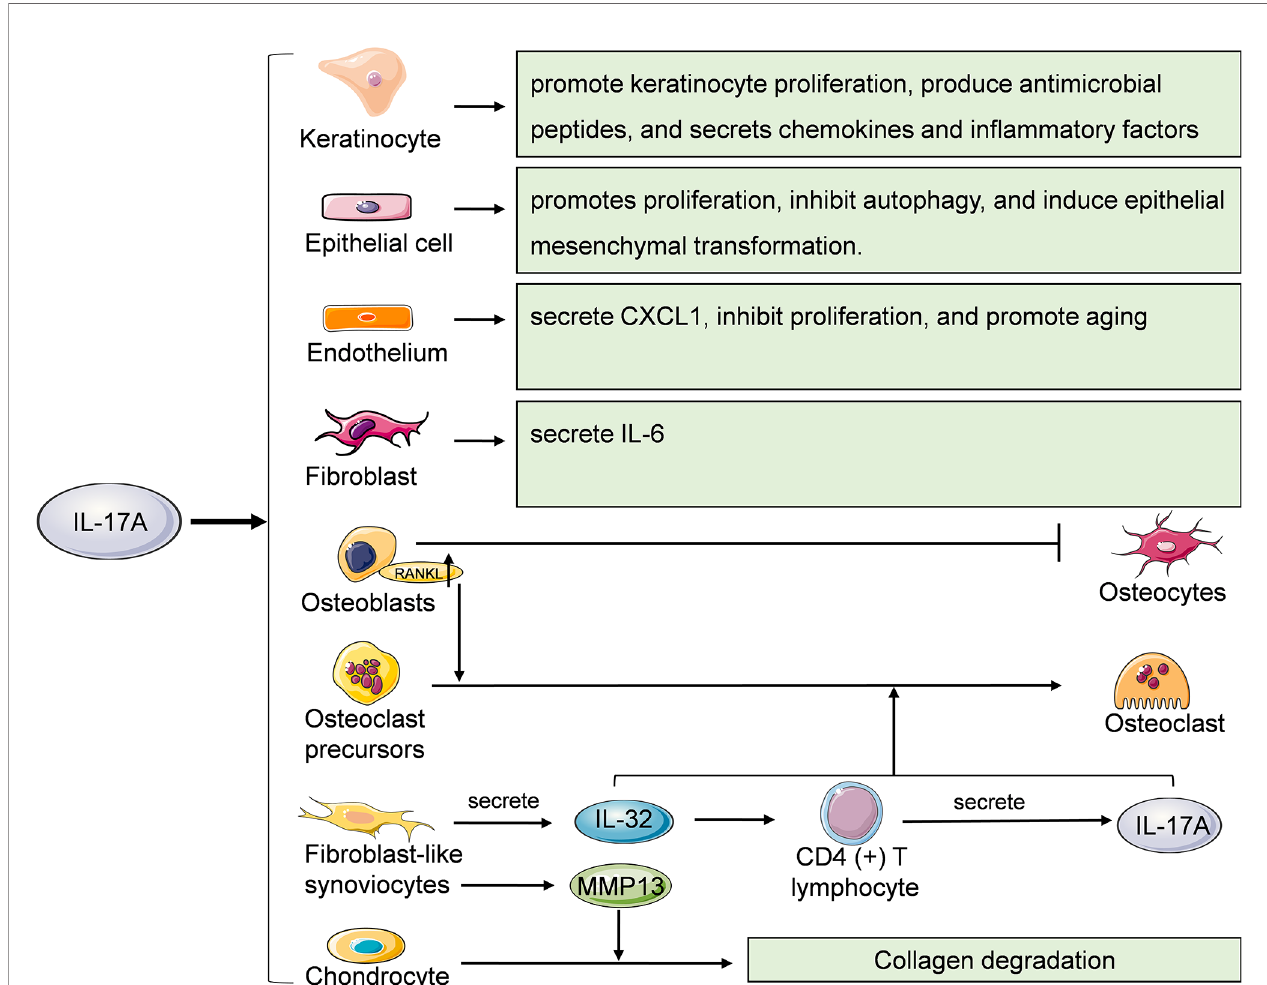
FIGURE 4 | Effects of IL-17A on other cells. Keratinocytes, epithelial cells, endothelial cells, fi broblasts, osteoblasts, osteoclasts, fi broblast like synoviocytes (FLSs) and chondrocytes are also cellular targets of IL-17A. RANKL, receptor activator of nuclear factor kappa B ligand; MMP13, matrix metalloproteinase